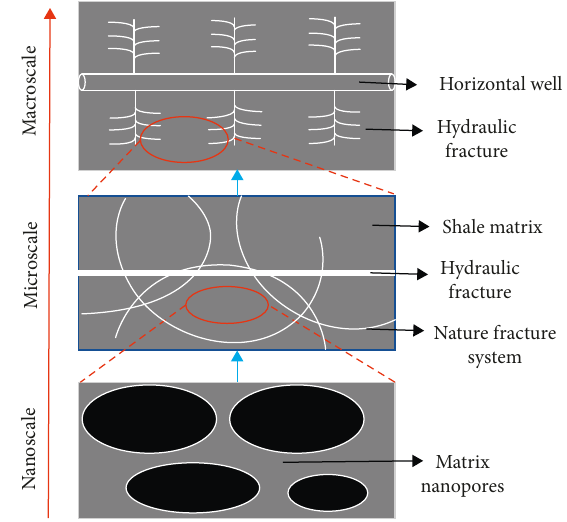
Figure 1: Physical model of gas